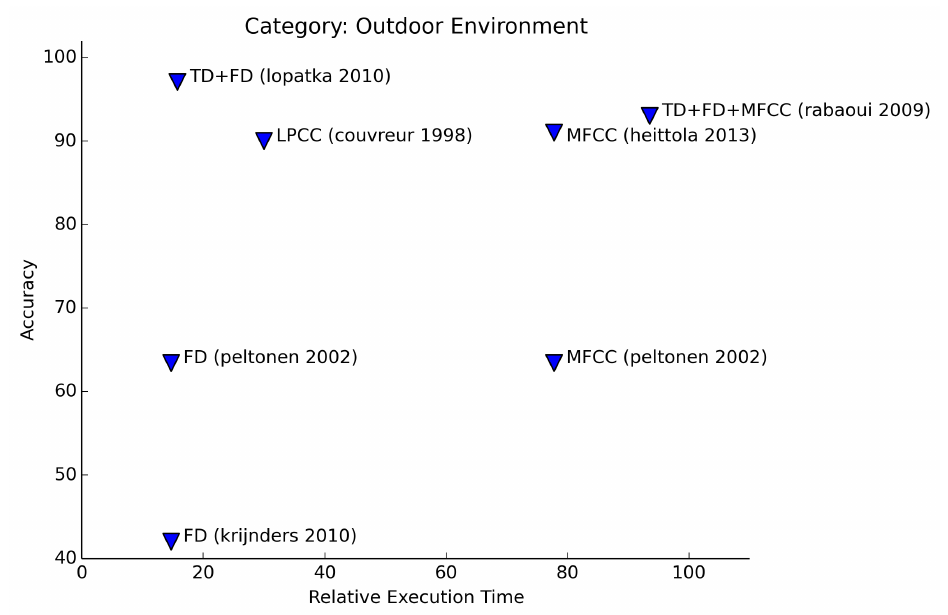
Figure 12. Relative execution time for outdoor environment